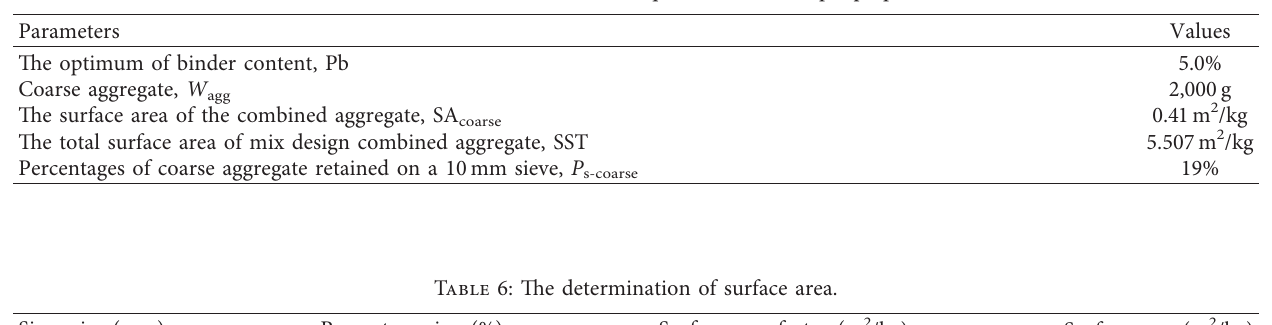
Table 5: The amount of materials required for the sample preparation.